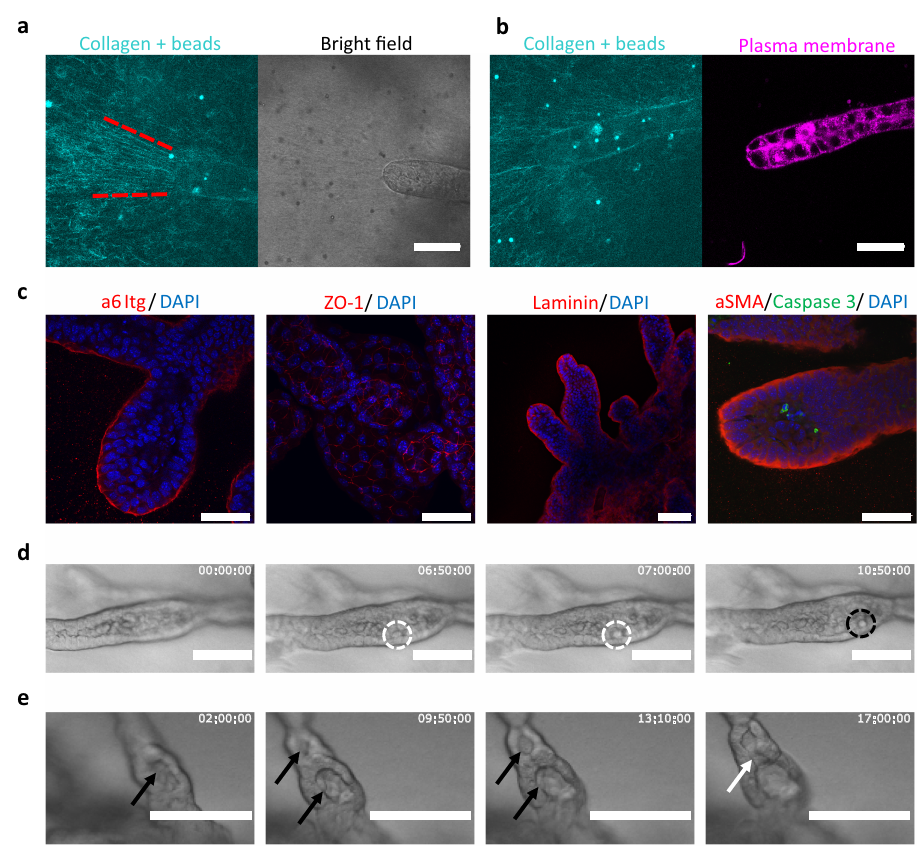
Fig. 3 | Organoids remodel their surrounding ECM, and develop lumens via different processes. All organoids shown here are grown in collagen. a Collagen fi bers visualized with re fl ection microscopy (cyan), in front of a thickening branch atDay10( n =2replicates).Thebranchispullingonthe fi bersinfrontofit,aligning theminacone,outlinedbythered-dashedlines.Scalebar:50 µ m. b Collagen fi bers visualized with re fl ection microscopy (cyan) around the branch of an organoid at Day 10 (plasma membrane stained in magenta, n =2 replicates). Scale bar: 50 µ m. c Fromlefttoright:stainingofDAPI(blue)and α 6integrins(red)amediatorofcell- ECM adhesion. Staining of DAPI (blue) and ZO-1 (red), a tight-junction associated protein. Staining of DAPI (blue) and Laminin (red) a major component of the basal lamina. Staining of α -smooth muscle actin (aSMA, red) a protein associated with